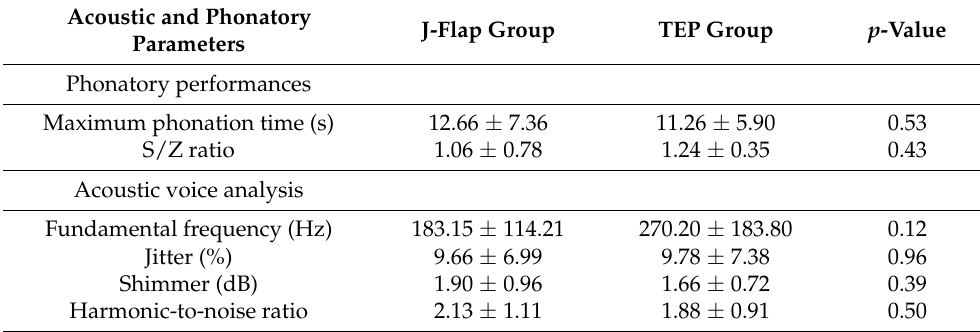
Table 3. Phonatory performances and acoustic voice analysis.